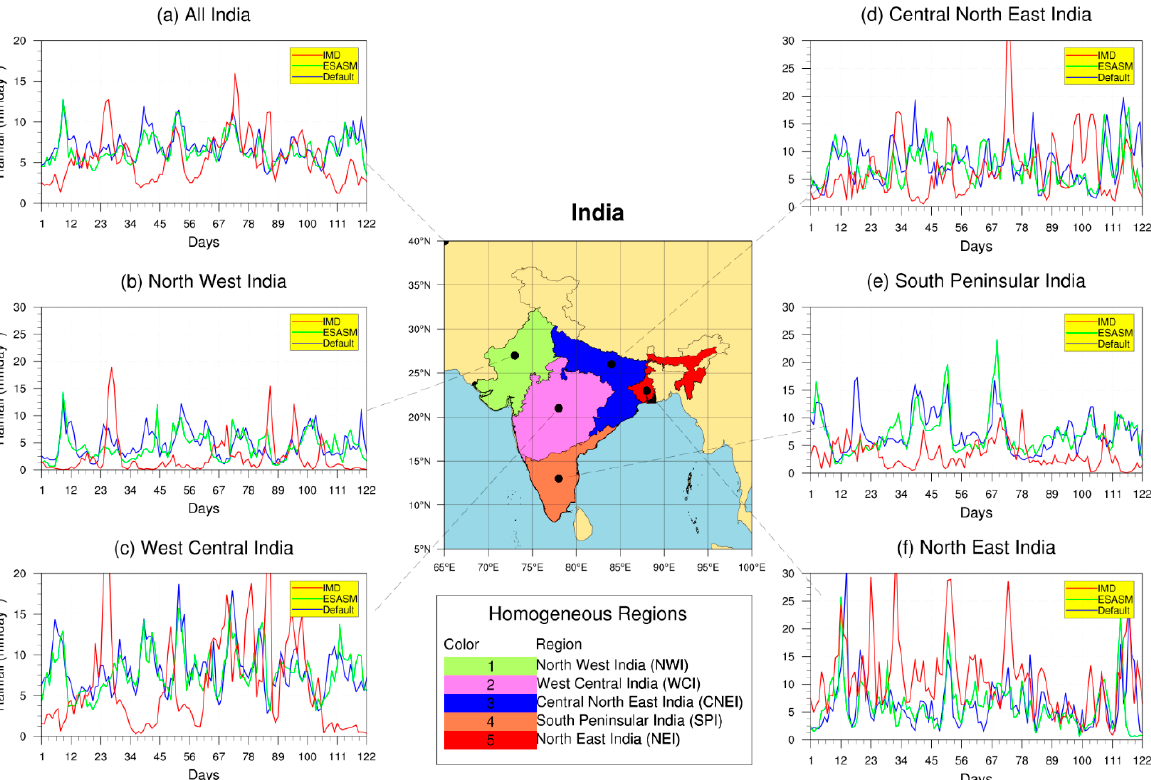
Figure 10. Daily variation of rainfall (mmday − 1 ) over ( a ) India and ( b – f ) five homogeneous regions derived from the two setups (default, ESA) and IMD analysis for the year 2002.